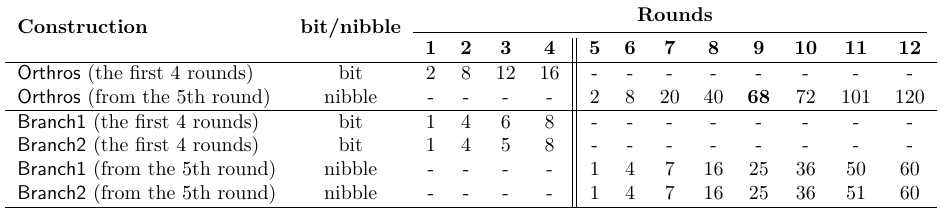
Table 8: The lower bounds of the number of active S-boxes in the single-key setting.